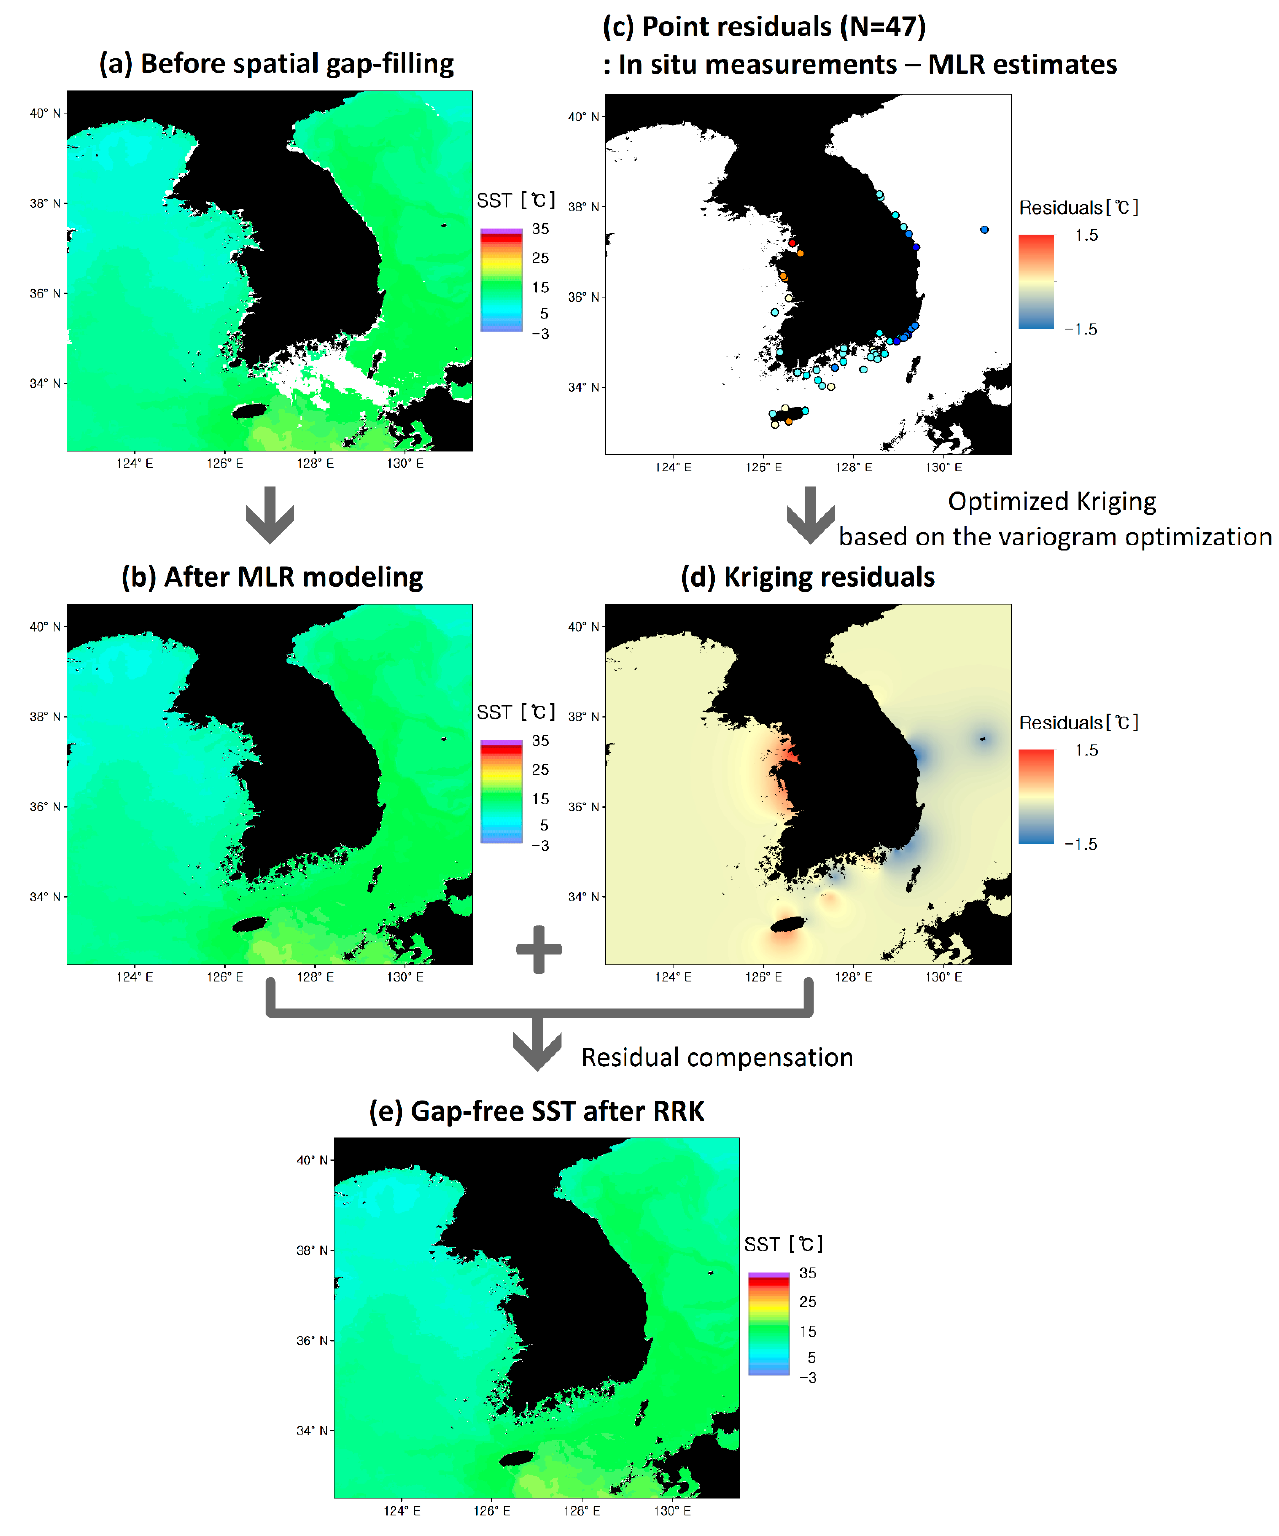
Figure 9. RRK process with the example of 10 April 2020. ( a , b ) denote images before spatial gap- filling and after MLR modeling, respectively. ( c ) point residuals, ( d ) kriging residuals, and ( e ) gap-free SST after RRK.